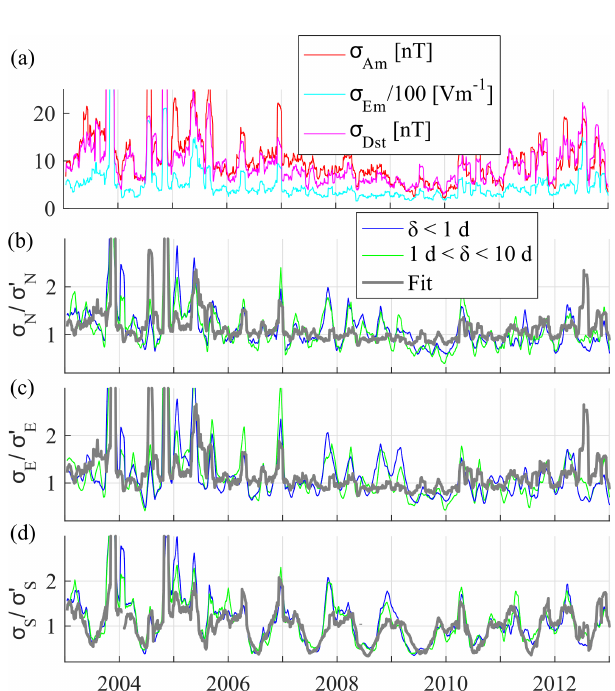
Figure 4. From top to bottom, (a) the 30d moving standard devi- ation of Am , Dst , and E m , and the solar-flux normalized 30d stan- dard deviation sliding window of residual density disturbances at an altitude of 475km at (b) the northern, (c) the equatorial, and (d) the southern regions. Fourier fits in terms of doy and E m are plotted in gray. Calculations filtered at different frequencies are plotted in green and